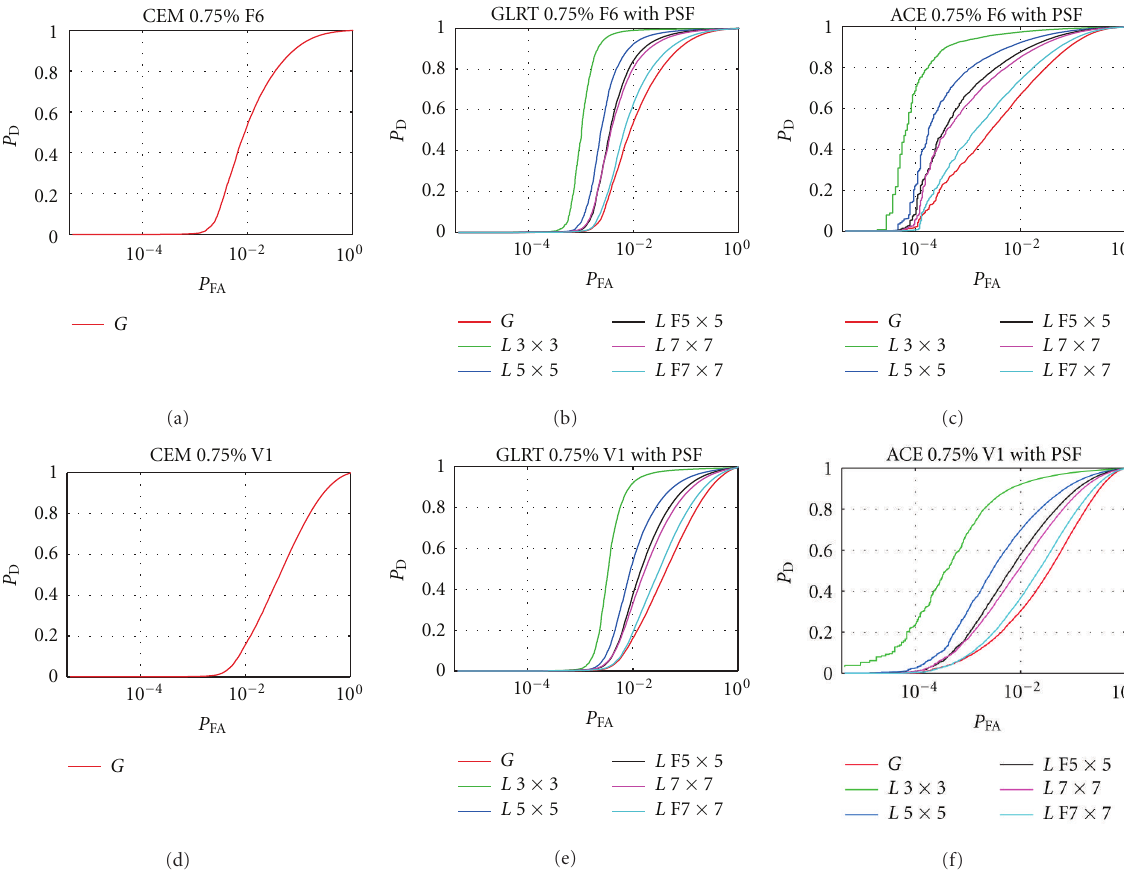
Figure 12: IRBTA results for di ff erent type of